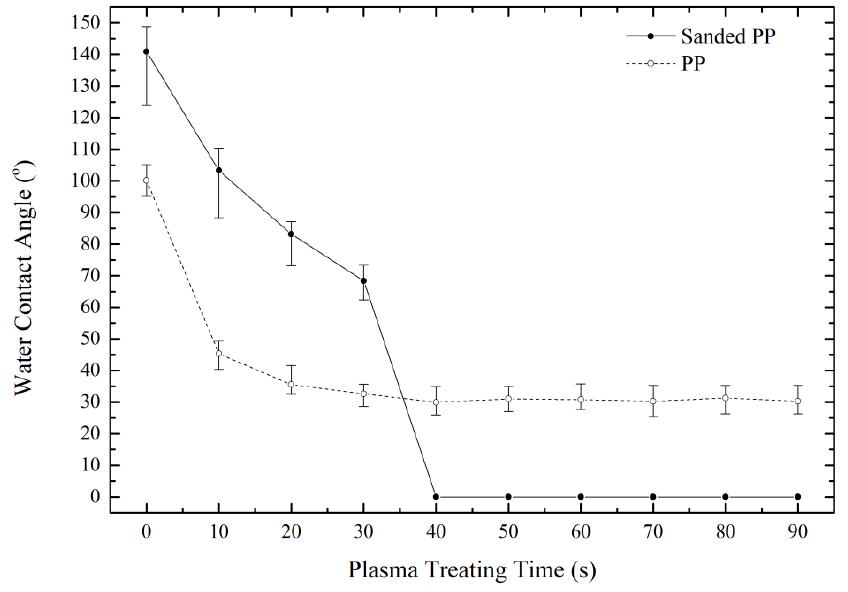
Figure 8. WCAs of PP films after various plasma treating times.